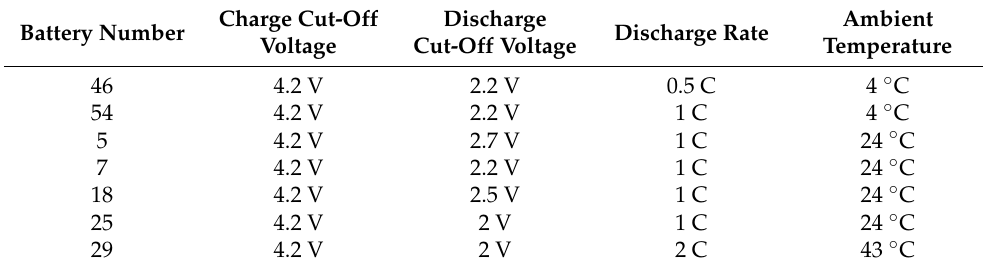
Table 1. Statistical table of experimental conditions for batteries. Charge Cut-Off Discharge Battery Number Voltage Cut-Off